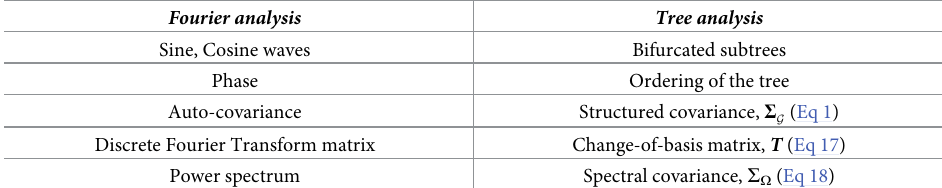
Table 2. Generalized spectral analysis. Well-known quantities in Fourier analysis have their direct analogs in the spectral analysis of a